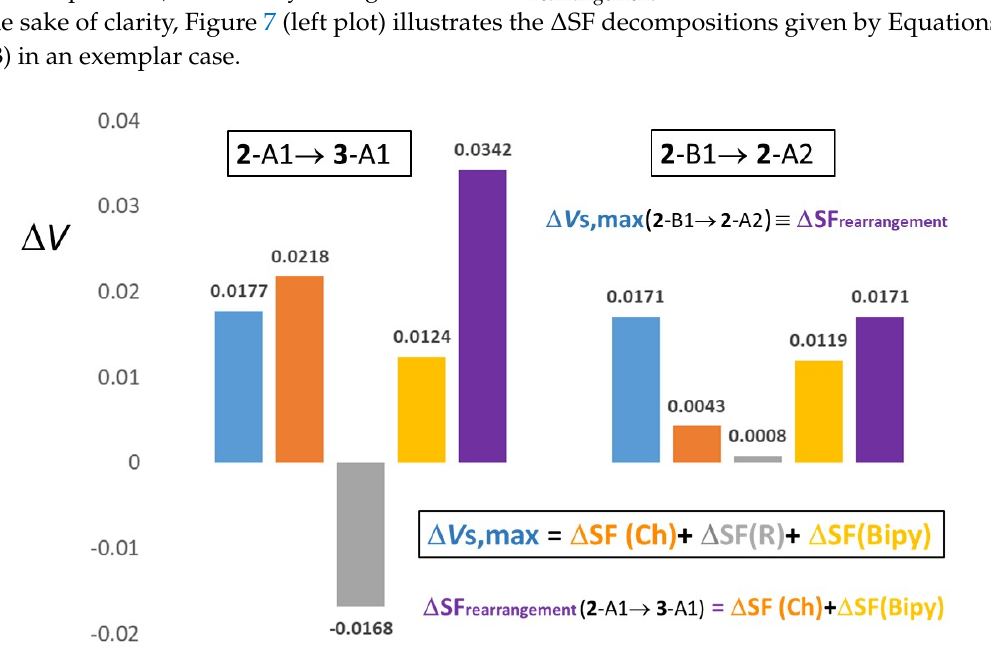
cases is shown, while ∆ SF substitution equals ∆ SF(Ch) for the 2 -A1 → 3 -A1 case and it is identically equal to zero for the 2 -B1 → 2 -A2